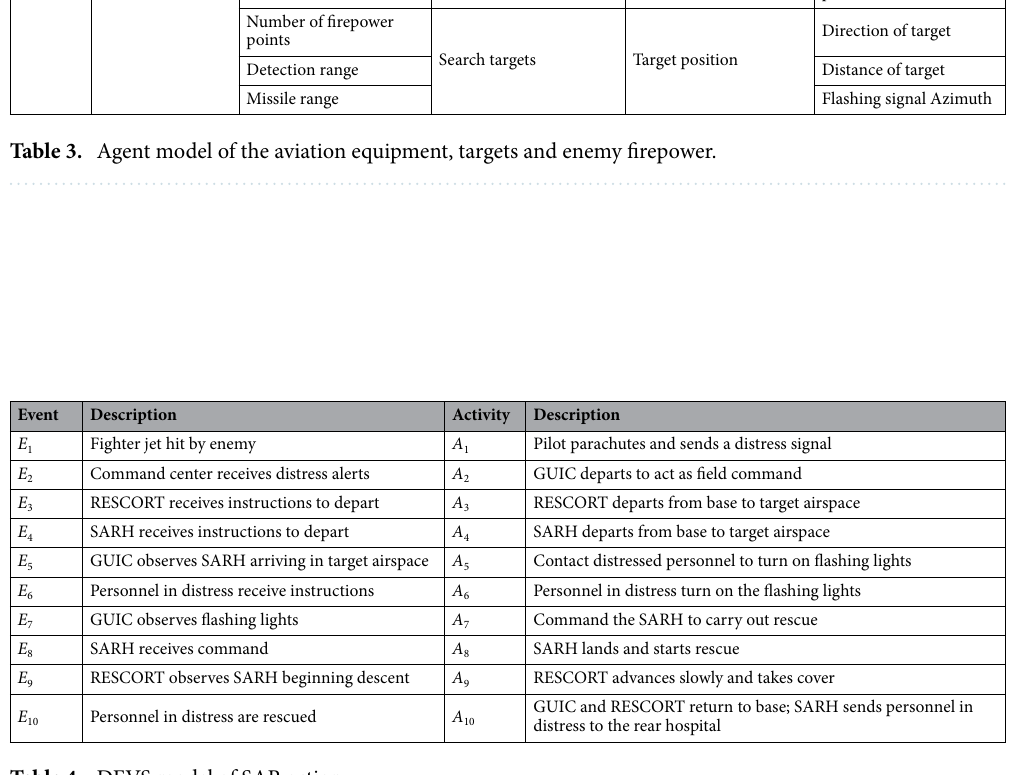
Table 4. DEVS model of SAR